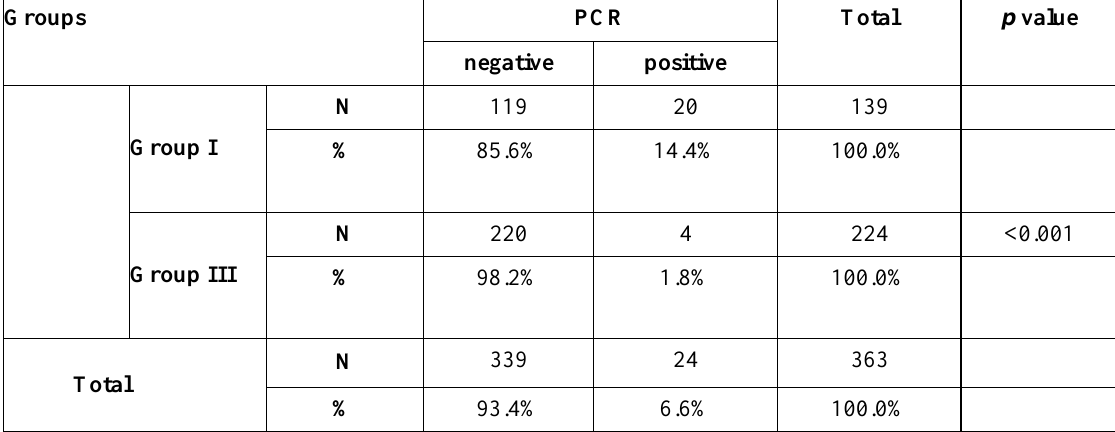
Table 4. Comparison of PCR results among group I and group III.